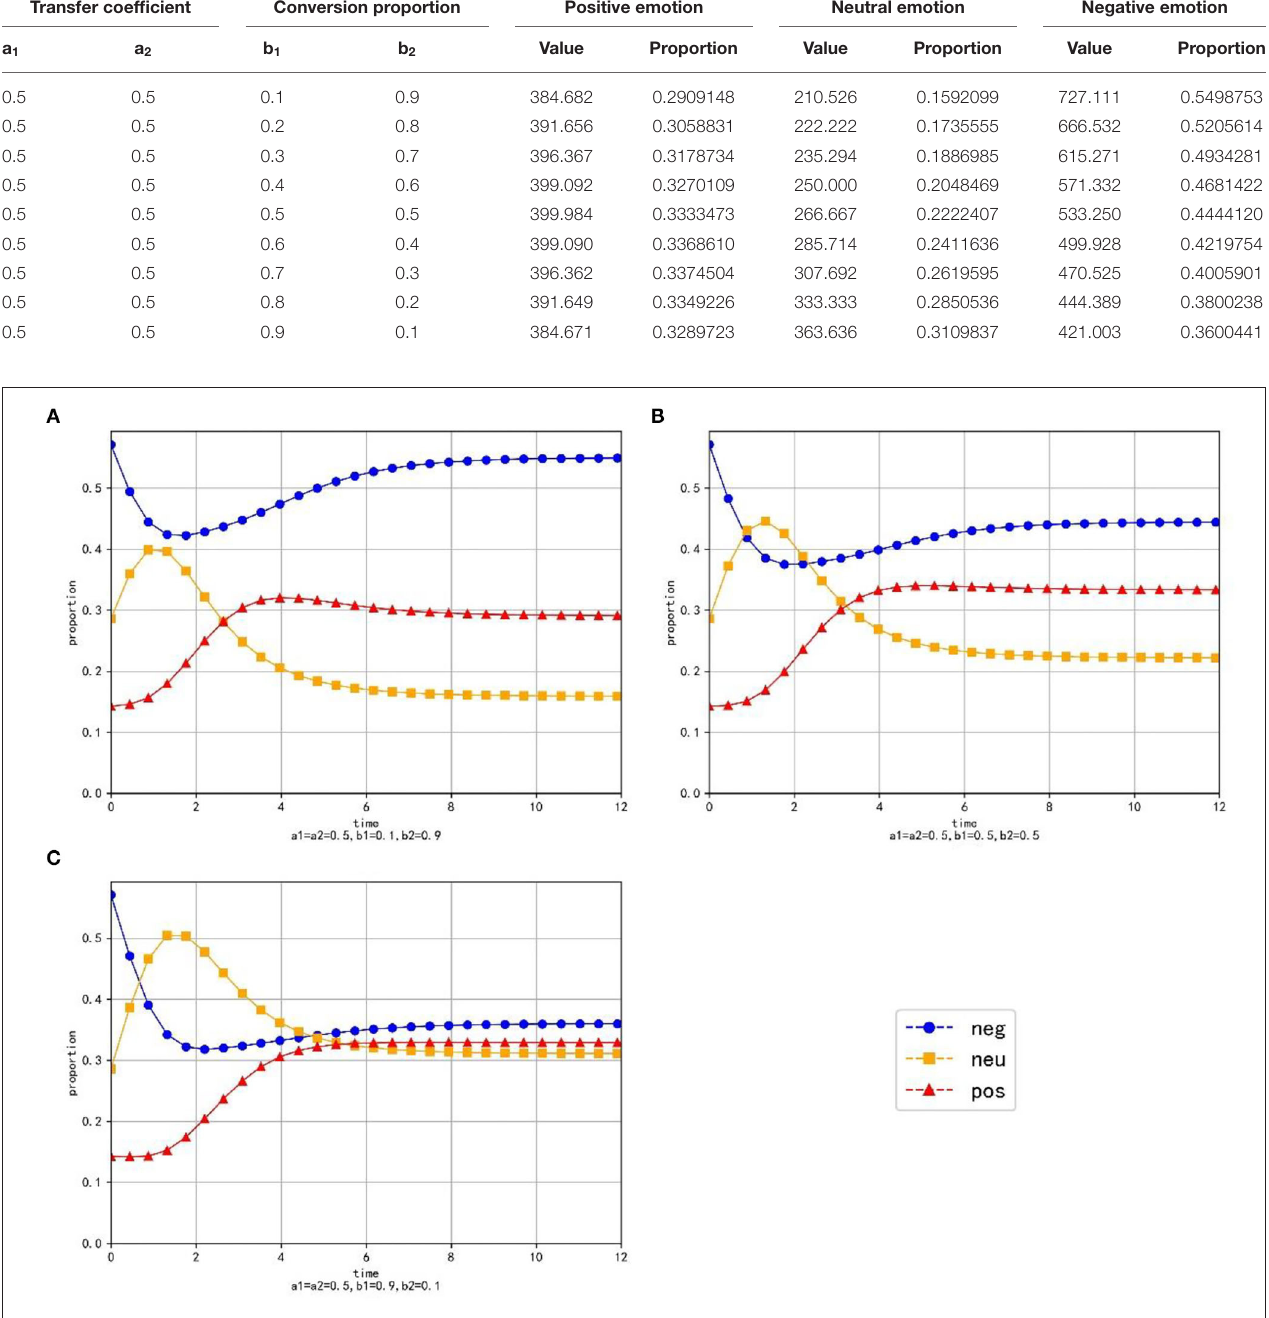
Simulation 2: Set a 2 = a 1 , b 2 = 1 − b 1 , where a 1 values 0.1, 0.2, 0.3, . . . , 0.9 in turn. For each value of a 1 , b 1 values 0.1, 0.2, 0.3, . . . ,